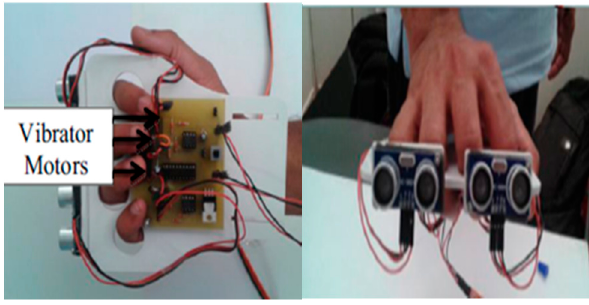
Figure 3. The prototype of the eye substitution device [20].